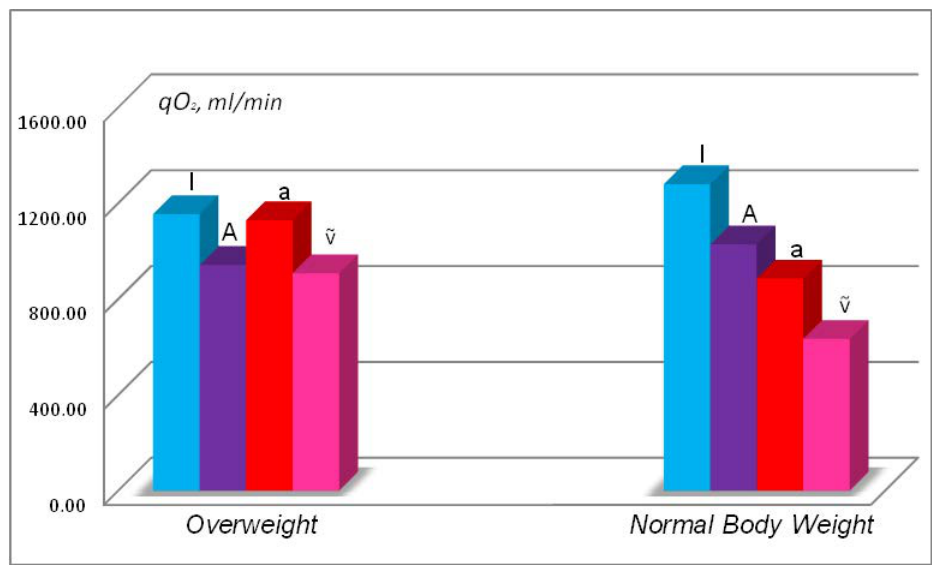
Figure 1. Rate of oxygen uptake in lungs (q I O 2 ), oxygen uptake in alveoli (q A O 2 ), oxygen delivery in arterial blood (q a O 2 ), and oxygen delivery in mixed venous blood (q ṽ O 2 ) in the same 170-cm tall at overweight (82 kg) and at normal body weight (70 kg).